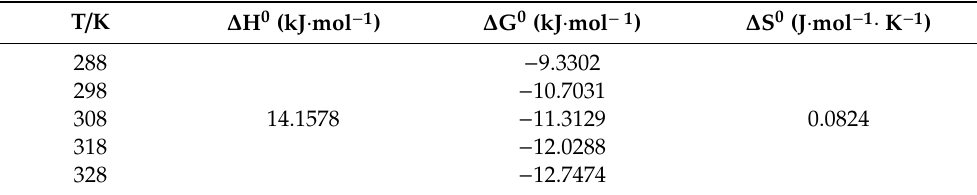
Table 4. Thermodynamic parameters of HHTB adsorption of